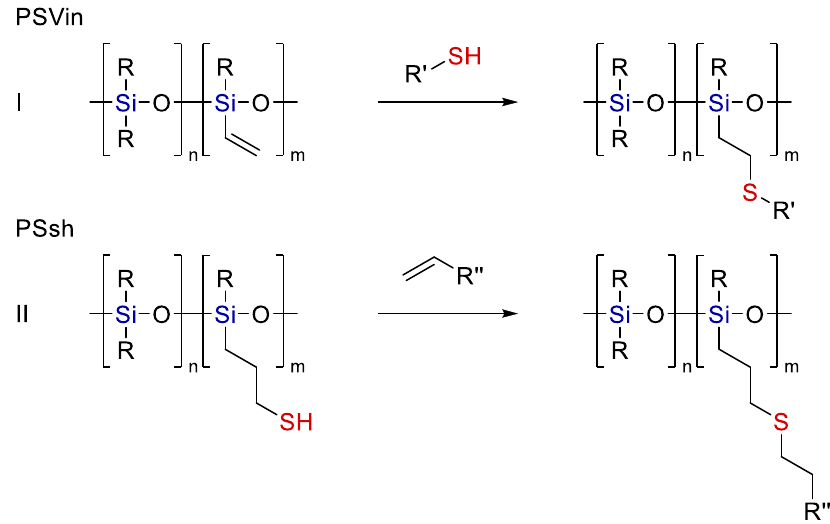
Figure 24. Variants for modification of polyorganosiloxane polymers by thiol-ene